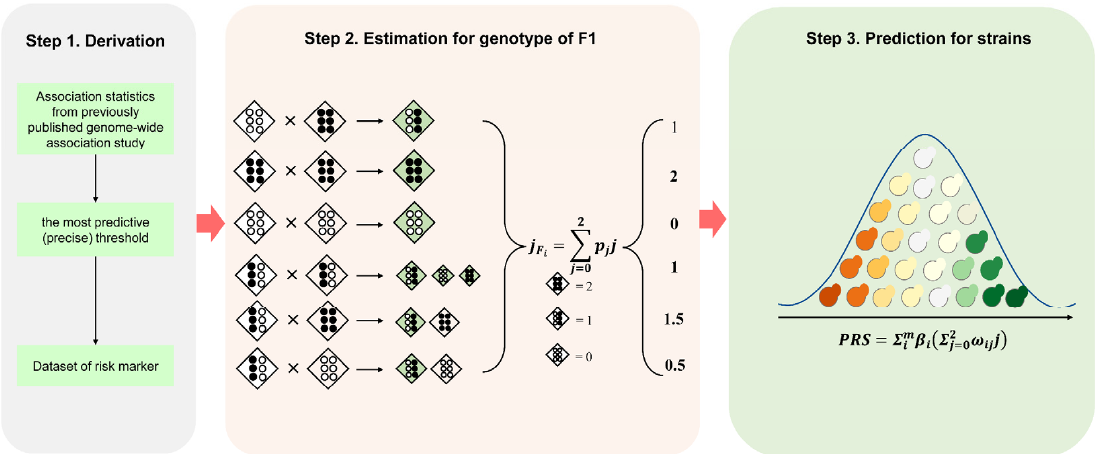
Figure 1. Study design and workflow. We developed a method for predicting the growth ratio of hybrid F1. The method consists of three main steps. First, to identify risk markers associated with the growth ratio, we downloaded the published GWAS summary results. We screened out the risk markers by calculating the precise p -value. Then, by estimating the genotypes of F1 hybrids according to the parental genotypes, we calculated their PRS. Finally, the potential of F1 was judged according to the value of